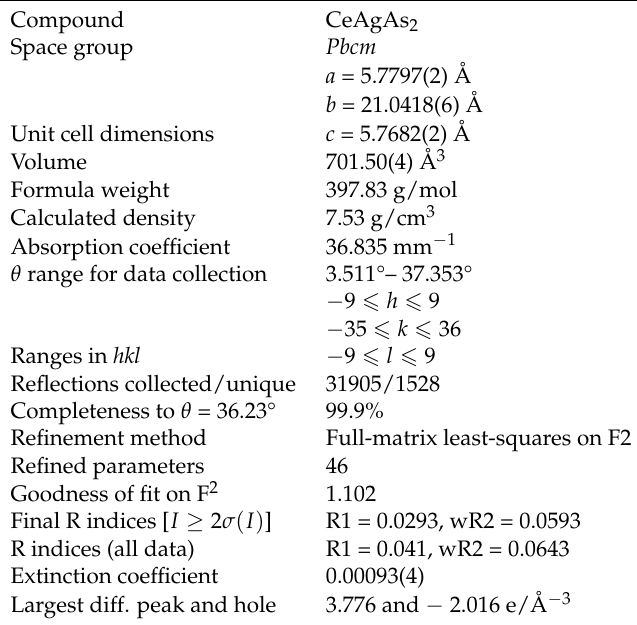
Table 1. Crystallographic and structure refinement data for CeAgAs 2